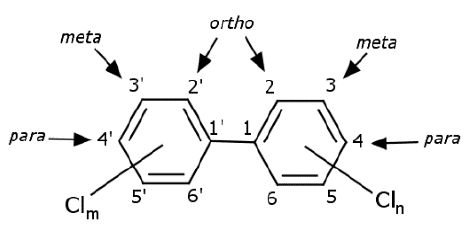
Figure 1. General chemical structure of chlorinated biphenyls.